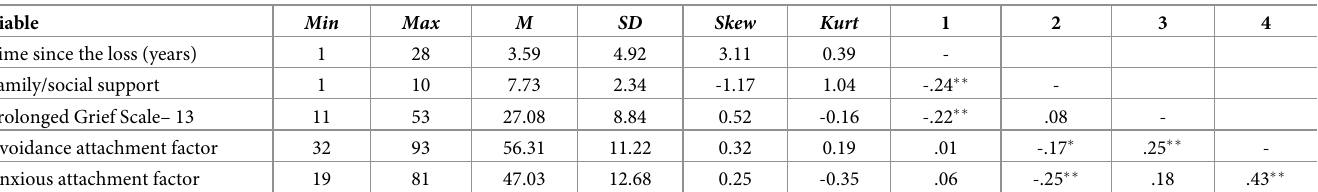
Table 3. Descriptive and correlational analysis ( N =